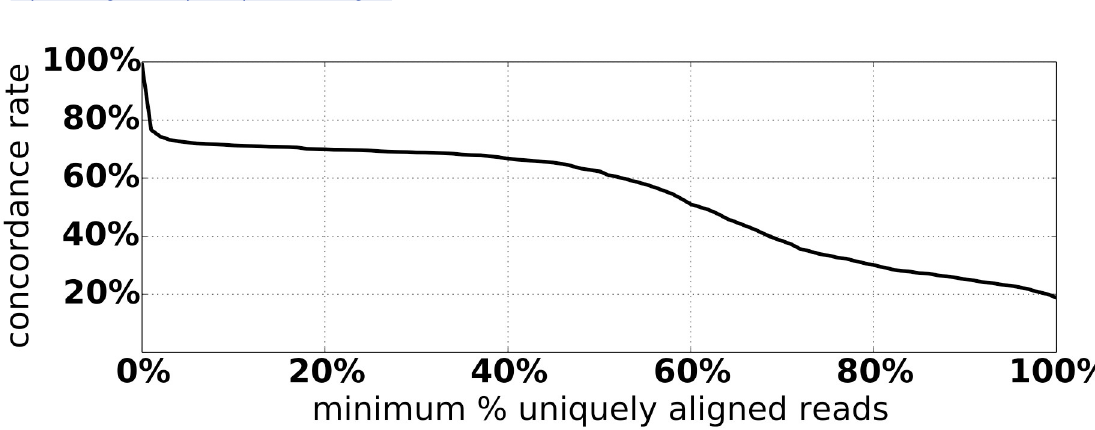
Fig 3. Concordance rate of Exogene and HIVID calls as a function of minimum coverage.